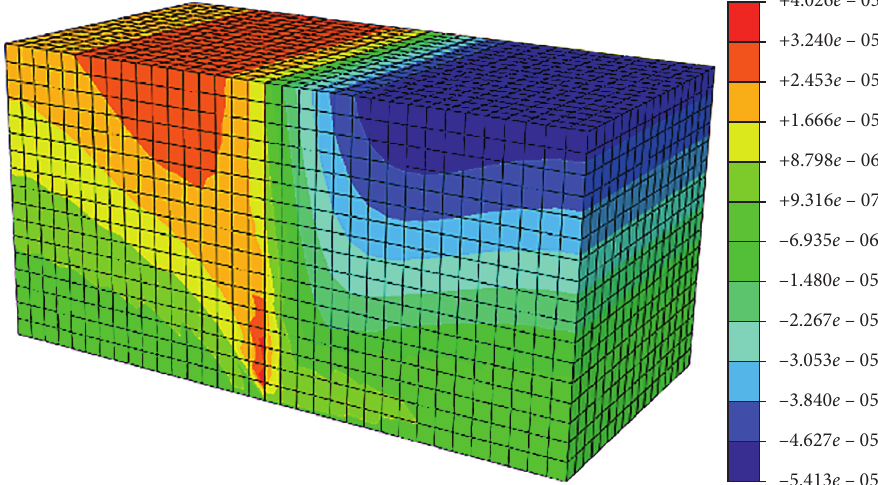
Figure 16: Vertical deformation contours of model 3 (unit: m).